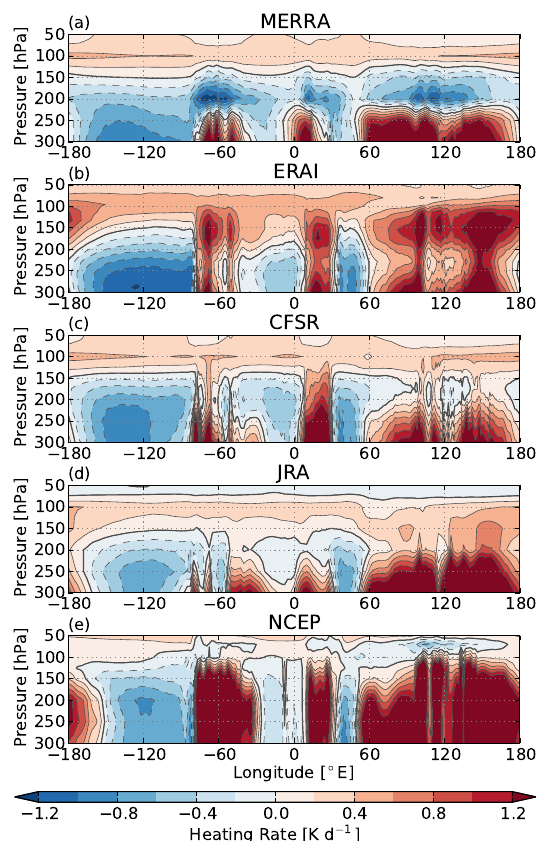
Fig. 3. Longitude-pressure distributions of diabatic heating aver- aged over 5 ◦ S to 5 ◦ N for the period